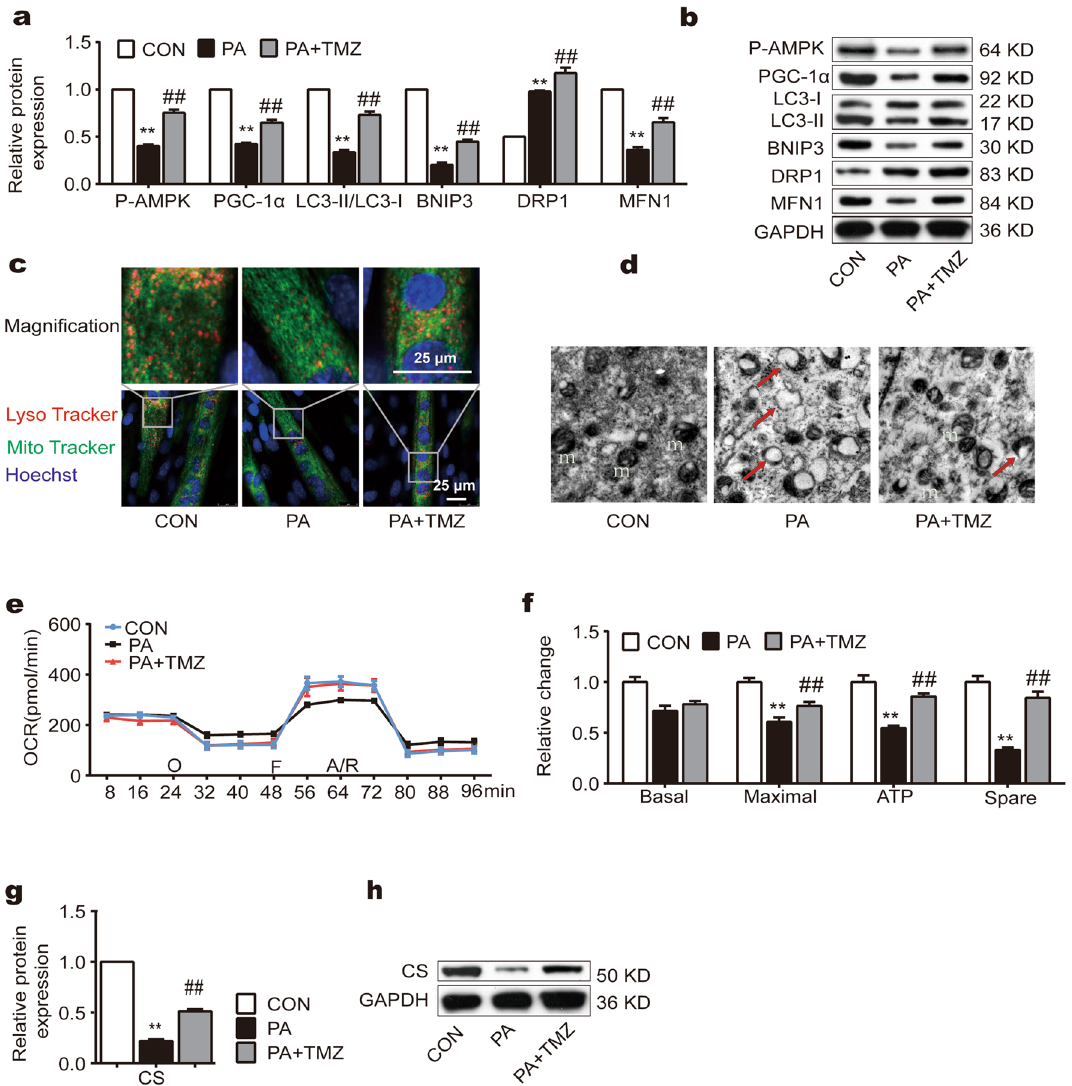
Figure 2. TMZ promotes PA-attenuated mitochondrial quality control (MQC) and functions in muscle cells. ( a , b ) P-AMPK, PGC-1α, LC3II/LC3I, BNIP3, MFN1, and DRP1 protein expression were determined by Western blot. ( c ) Laser scanning confocal microscope by using LysoTracker and mitoTacker. The colocalizations of lysoTracker and mitoTracker represented mitolysosomes (scale bar = 25 μm). ( d ) Transmission electron microscope imaging. The damaged mitochondria were indicated in TEM images (red arrow). ( e , f ) OCR: cellular oxygen consumption. m: mitochondria. ( g , h ) CS protein expression was determined by Western blot. *, ** represented p < 0.05, p < 0.01 in comparison with the Con group, respectively; # , ## represented p < 0.05, p < 0.01 in comparison with the PA group,